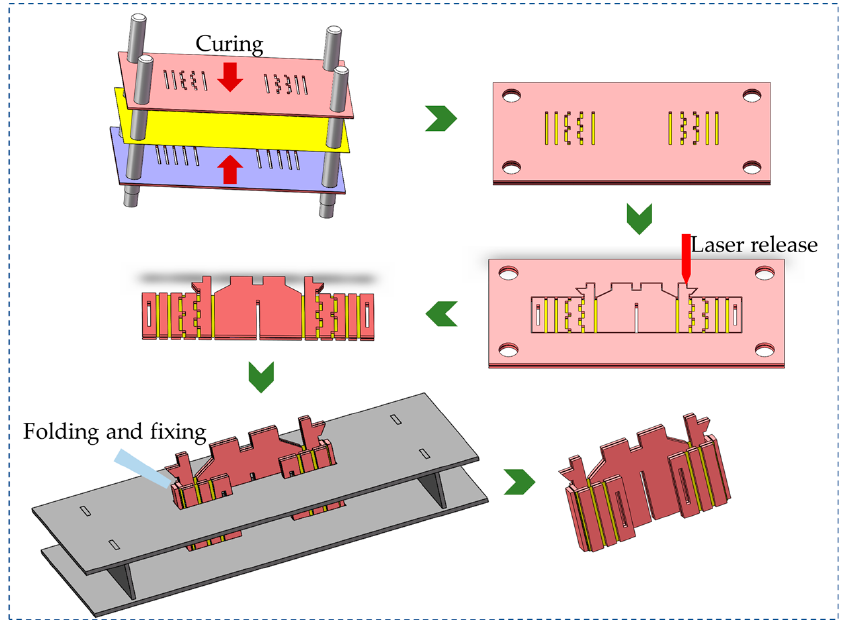
Figure 3. The whole manufacturing idea of the flapping ‐ wing micro air vehicle.